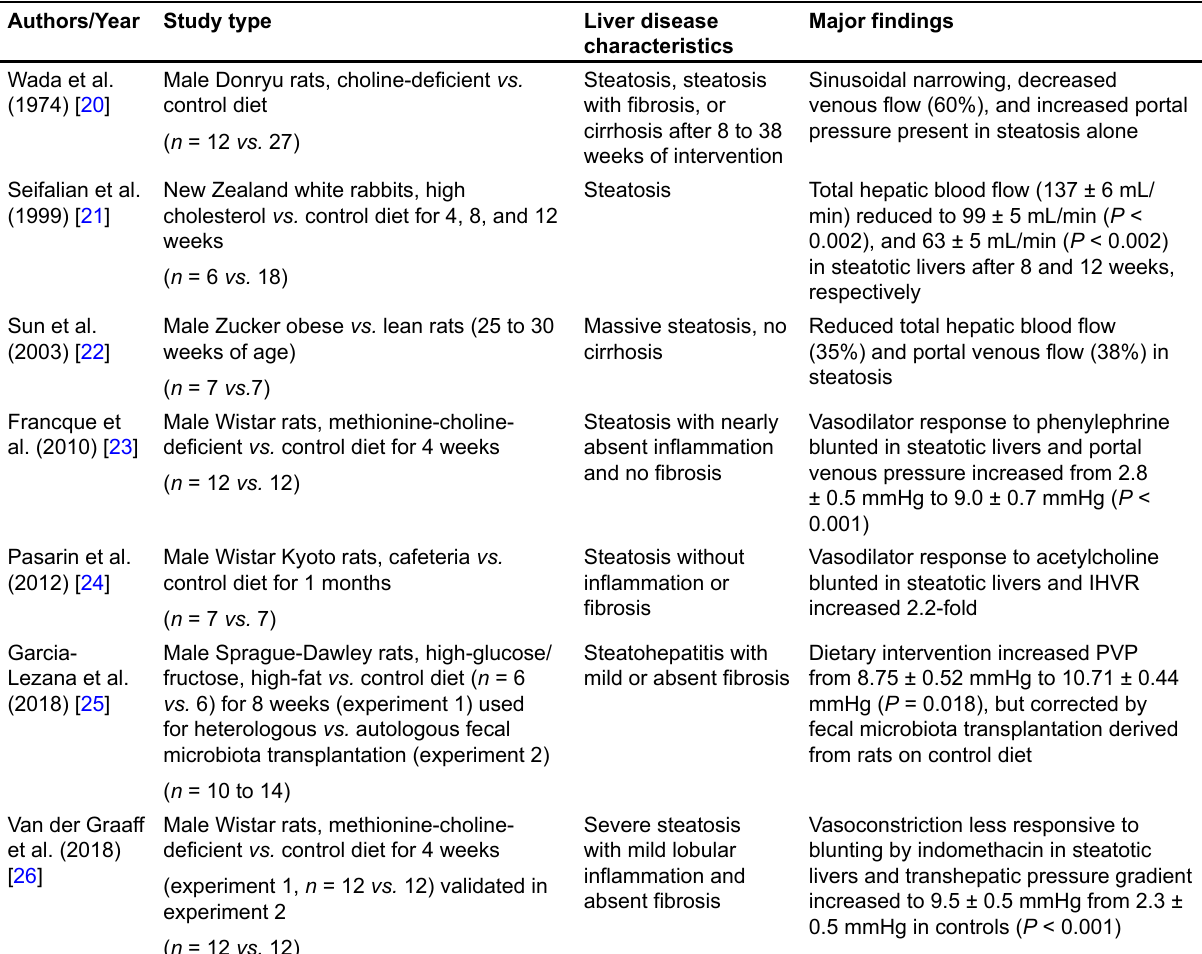
Table 1. Changes in hepatic vascular parameters reported in experimental NAFLD Authors/Year Study type Liver disease